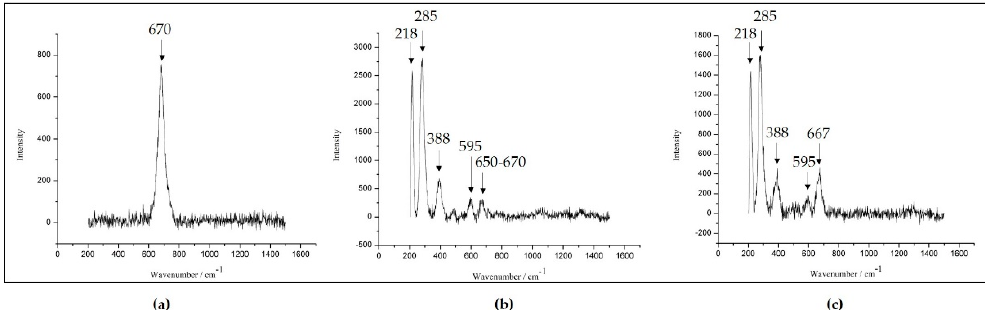
Figure 6. Raman spectra of wüstite inclusion observed at different laser powers, 0.5 mW ( a ) and 5 mW ( b , c ); sample DL50 from Di Linh ( a , b ) and sample PT49 from Binh Thuan ( c ).